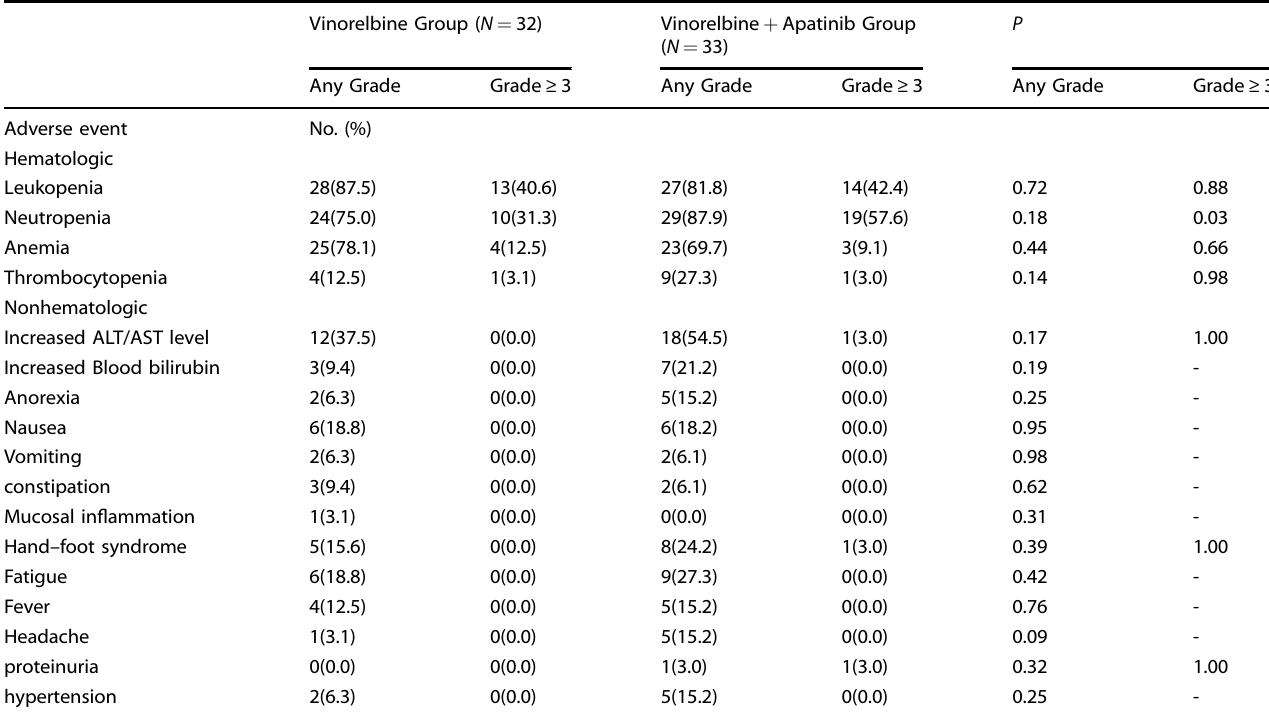
Table 3. Summary of adverse